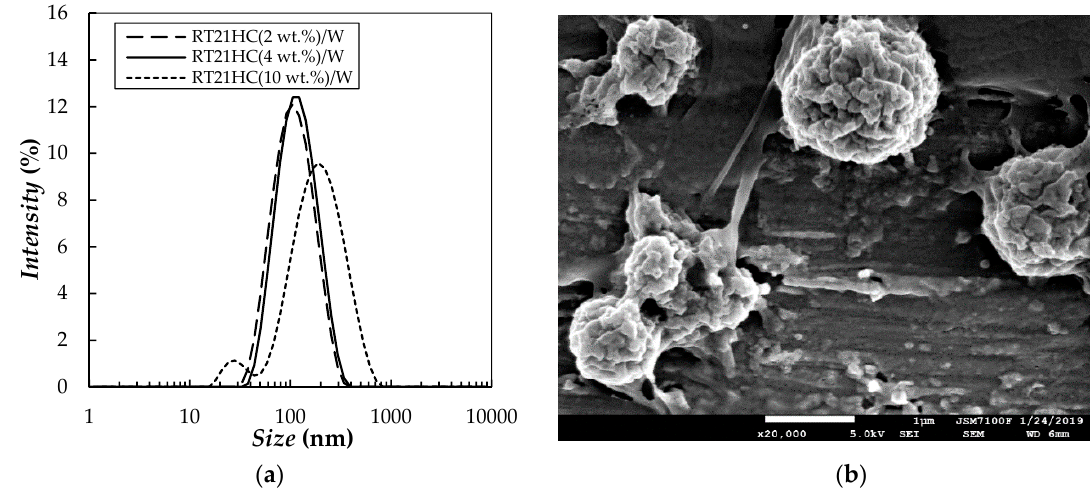
Figure 1. ( a ) Hydrodynamic droplet size distributions obtained by DLS [32] after PCME preparation and ( b ) SEM image of 4–month old RT21HC(2 wt.%)/water emulsion (1:20 diluted).